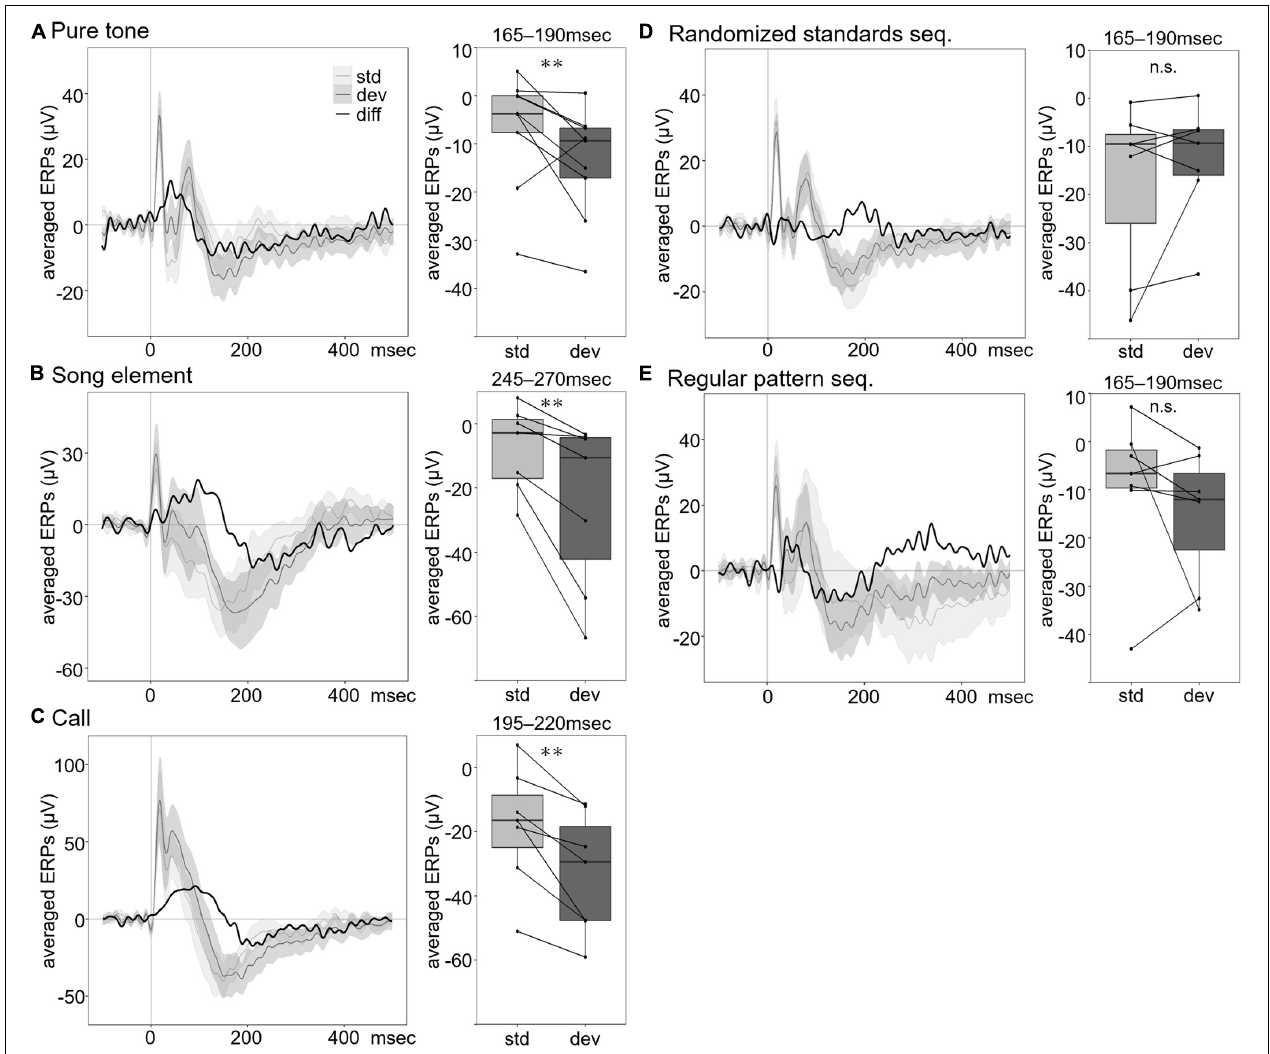
FIGURE 2 | Averaged ERPs to standard and deviant stimuli and averaged ERP amplitude at the specified time window. Group averaged ERPs to the oddball standard (light gray line) and deviant (dark gray line) stimuli for pure tones (A) , song elements (B) , and calls (C) . Comparison between group averaged ERPs of deviant stimuli in the oddball sequence and that of the standard stimuli in the randomized standard sequence (D) and the regular pattern sequence (E) . Black line shows the difference wave obtained by subtracting the ERP to standard stimuli from the ERP to deviant stimuli. The shading indicates the range of 95% CI of the waves. In the box plot on the right of the waveform, each box shows the quartiles of the ERPs to standard (light gray) and deviant (dark gray) stimuli at each time window (pure tone: 165–190 ms, song element: 245–270 ms, and call: 195–220 ms, after stimulus onset) in each sound sequence. Each dot represents the averaged ERPs for each individual (pure tone: n = 9, song element: n = 7, and call: n = 7). Averaged ERPs to deviant stimuli negatively shifted, compared with that of standard stimuli in the single oddball sequence, while no significant difference was found compared with averaged ERPs to standard stimuli in the randomized standard sequence ( n = 7) and the regular pattern sequence ( n = 7) (repeated measures ANOVA, ∗∗ p < 0.01). n.s., no significance.